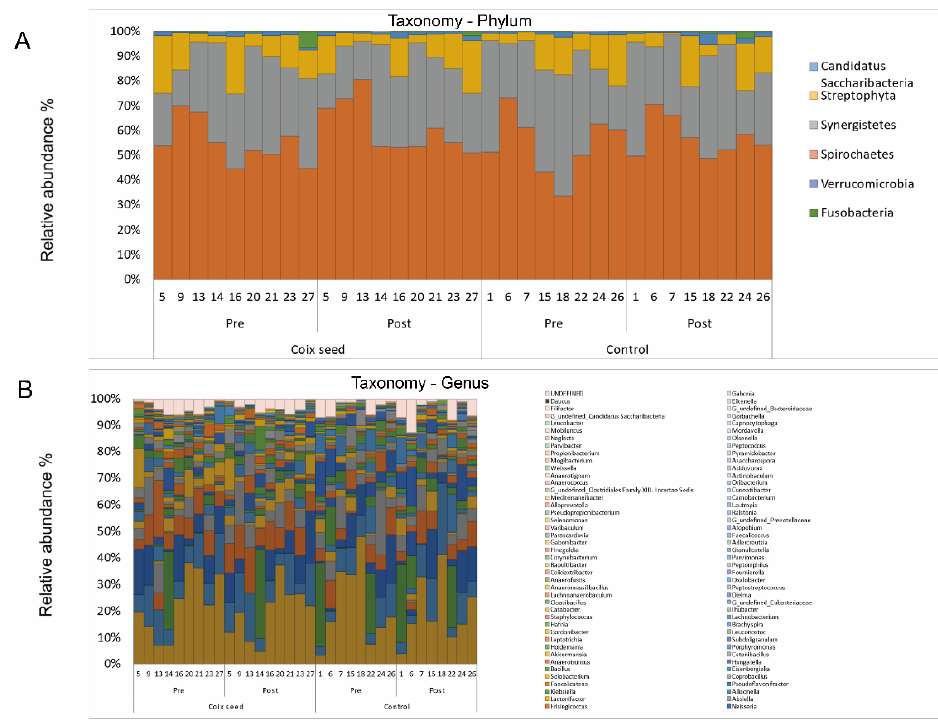
Figure 2. Phyla ( A ) and genera ( B ) of the gut bacteria identified in each sample of feces, before and after the consumption of coix seed for 7 days.